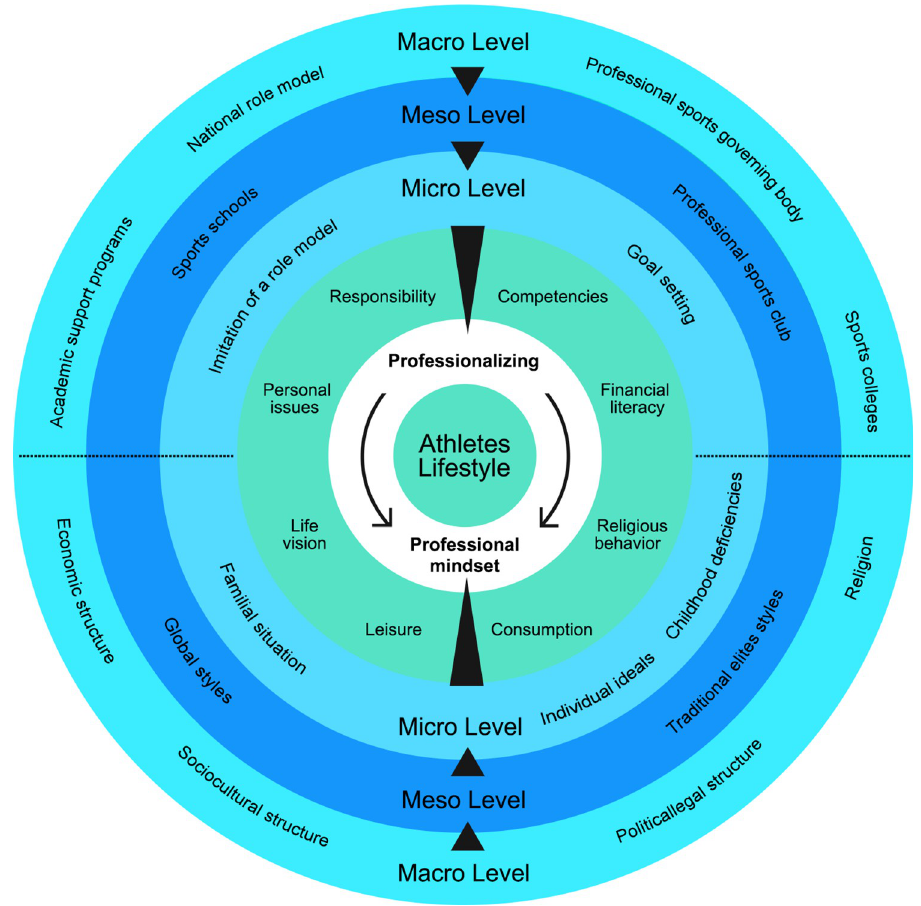
Fig 1. Conceptual map of elite athlete’s